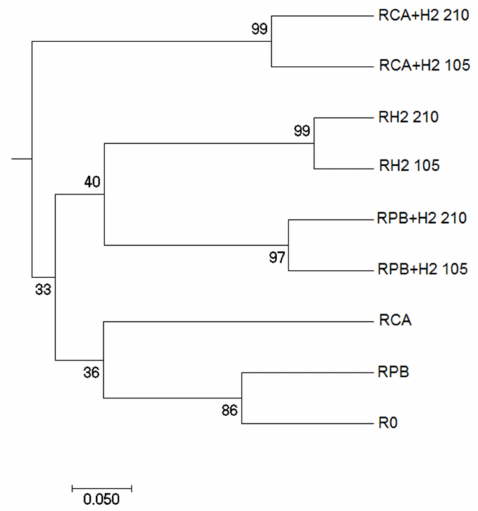
Figure 2. The dendrogram plotted on the basis of the zero-one matrix, based on the Denaturing Gradient Gel Electrophoresis (DGGE) pattern of amplicons obtained as a result of DNA amplification with NosZ-F/NosZ1622R